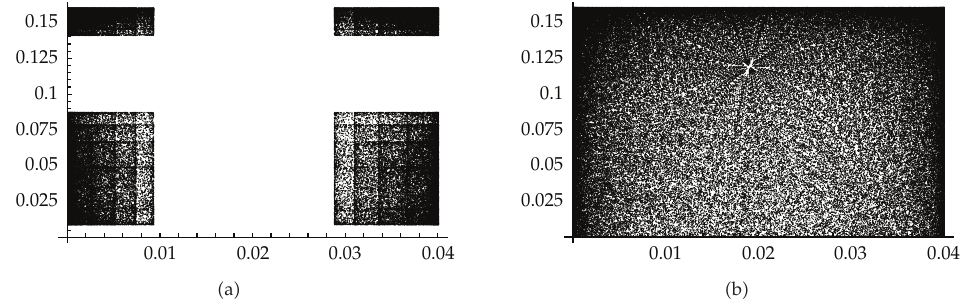
Figure 7: Attractors of type A3 for a (cid:6) 6 . 24 (cid:4) a (cid:5) . For the limit case a (cid:6) 6 . 25 we receive a dense orbit on the rectangle, which is the attractor of the system (cid:4) b (cid:5) .